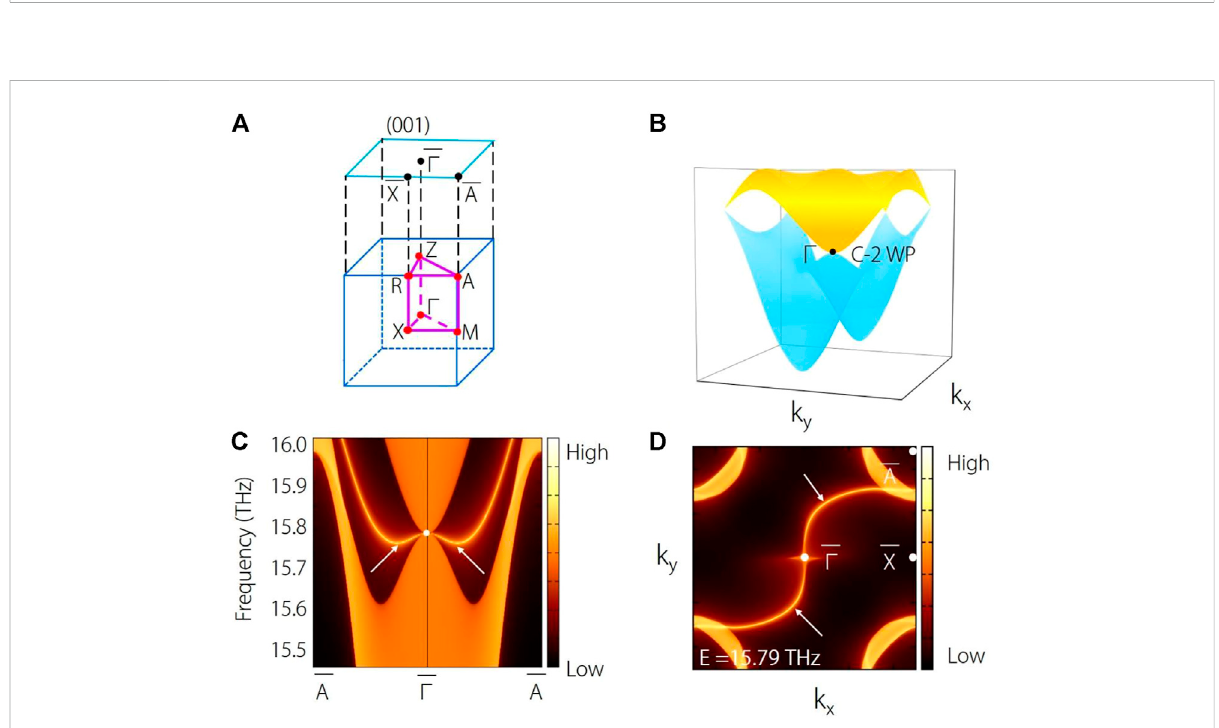
FIGURE 4 (A) ThebulkBZandthecorresponding(001)surfaceBZ. (B) Three-dimensionalplotofthephononbandsaroundthecharge-twoWeylpoint(C- 2 WP) at Γ . (C) Projected spectrum on the (001) surface, and (D) the corresponding constant frequency slice at 15.79